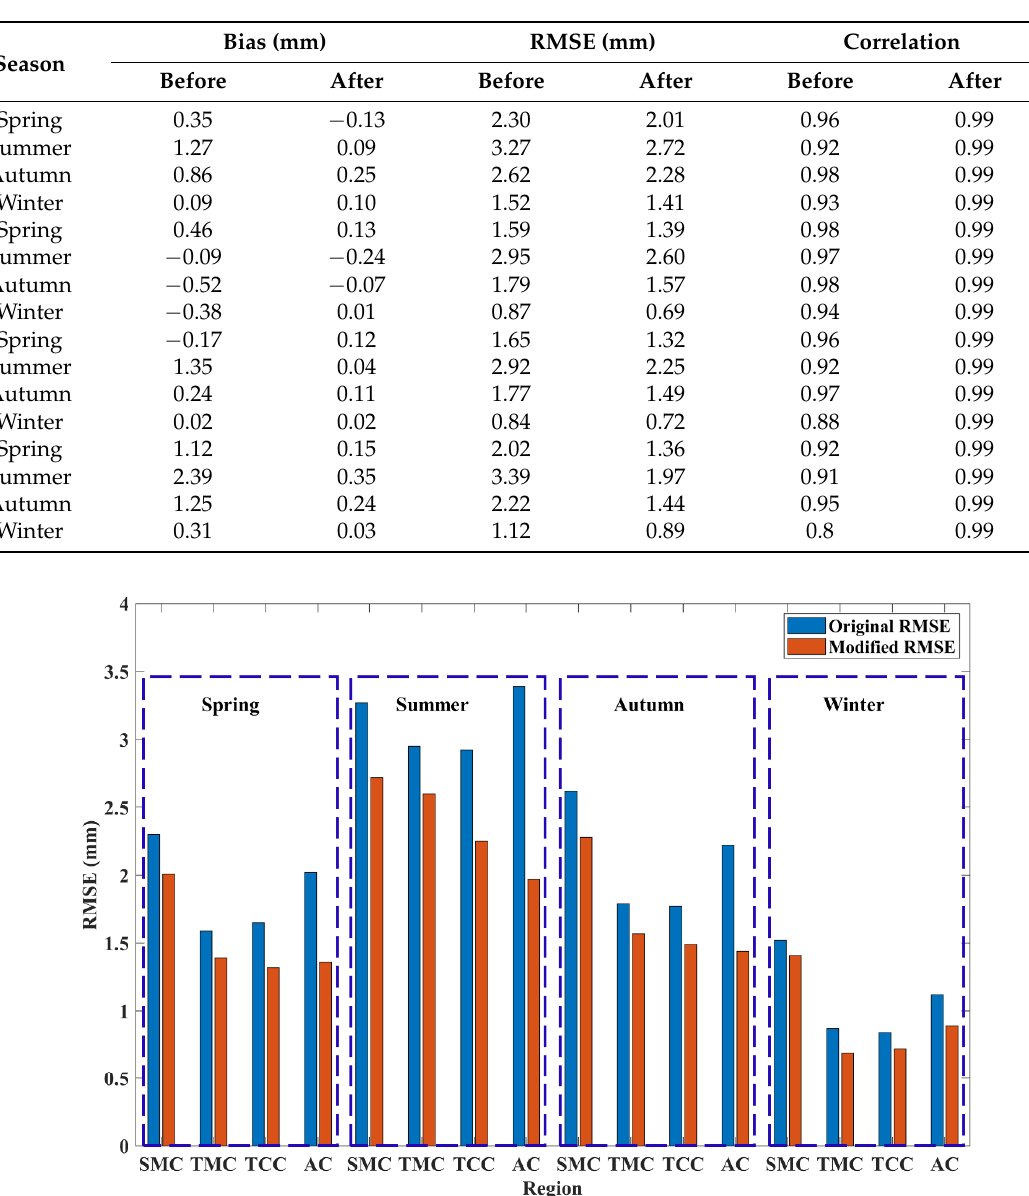
Table 3. Comparison of the ERA5 PWV and GNSS PWV before and after model fusion.